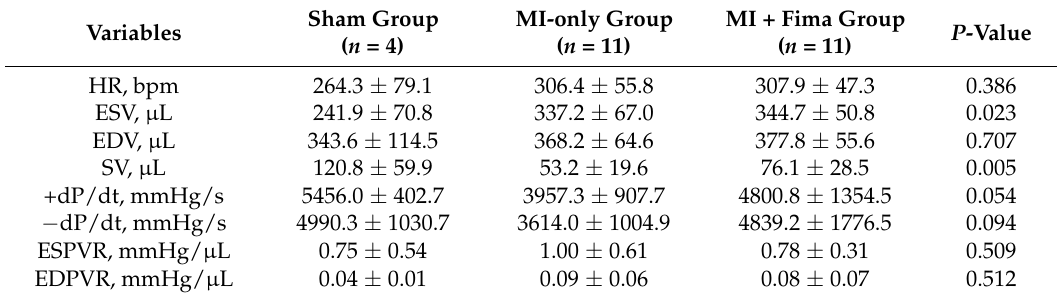
Table 2. The hemodynamics measurements at week 7 after a myocardial infarction.